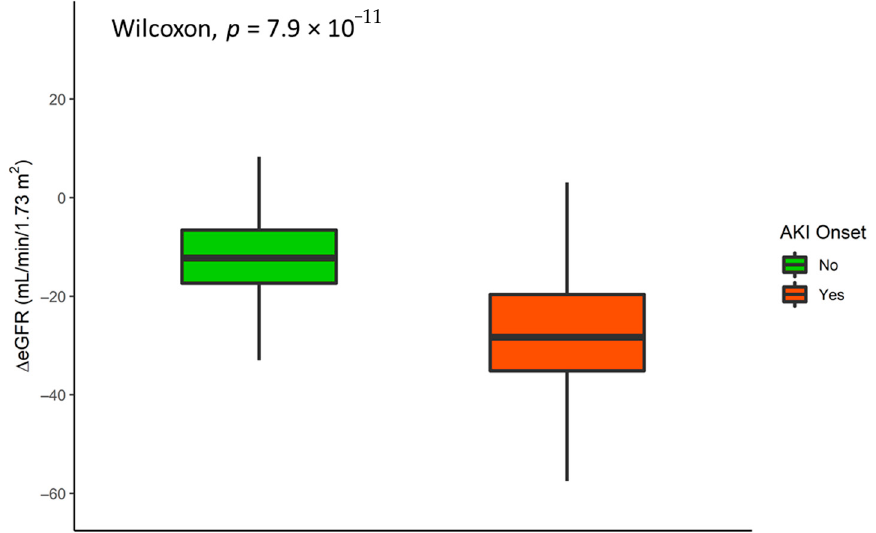
Figure 3. eGFR decay (baseline–after one year) distribution according to AKI onset.